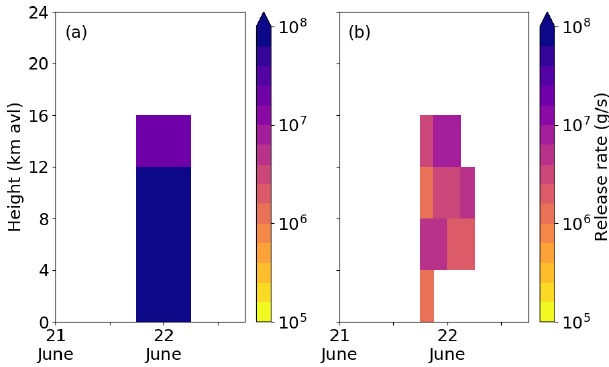
Figure 3. Total fine ash emitted during the 2019 Raikoke eruption for each member in the MOGREPS-G ensemble determined using InTEM. Blue circles and grey bars indicate the peak in the posterior distribution and range ( ± one standard deviation) of the total ash emitted. The black dashed line indicates the ensemble mean total fine ash emissions.